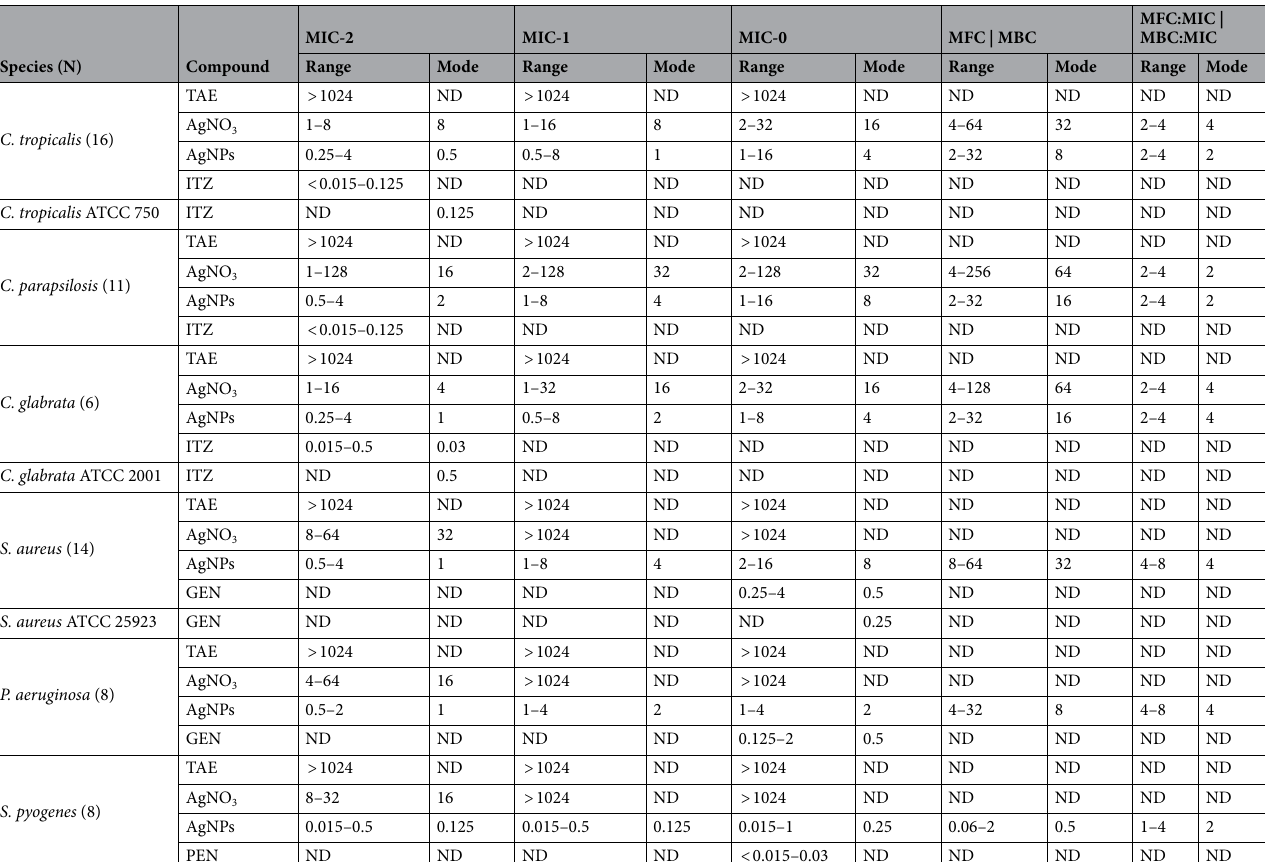
Table 2. Range and mode values of MIC-0, MIC-1, MIC-2, MFC, MBC and MIC:MFC or MBC:MIC of the aqueous extract of A. australe (TAE), silver nitrate (AgNO 3 ), silver nanoparticles (AgNPs), itraconazole (ITZ), penicillin (PEN) and gentamicin (GEN) against the microorganisms tested. All MIC, MFC and MBC data were expressed as μg lyophilized extract/mL for TAE and μg silver/mL for AgNO 3 and AgNPs. ND: Not determined. MIC-2: the lowest concentration capable of inhibiting ≥ 50% of microbial growth compared to the growth control. MIC-1: the lowest concentration capable of inhibiting ≥ 80% of microbial growth compared to the growth control. MIC-0: the lowest concentration capable of inhibiting 100% of microbial growth. Compounds with MIC values > 1024 μg/mL were considered inactive. A compound was considered bactericidal or fungicidal if the ratio (MFC:MIC or MBC:MIC) was ≤ 4, and bacteriostatic or fungistatic if the ratio was >